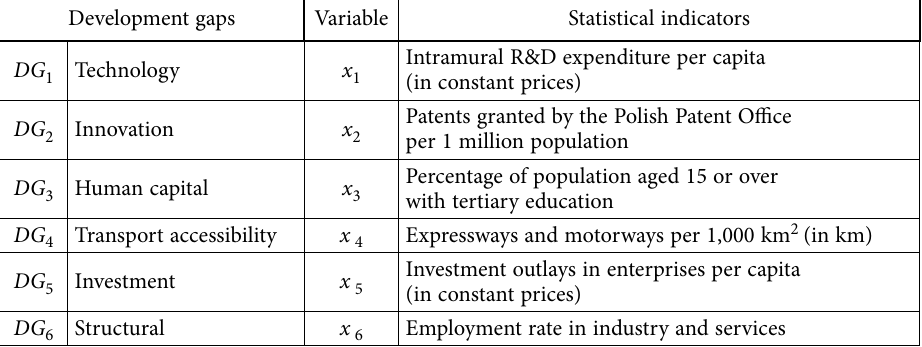
Table 1. Development gaps in EP regions (source: own study) Development